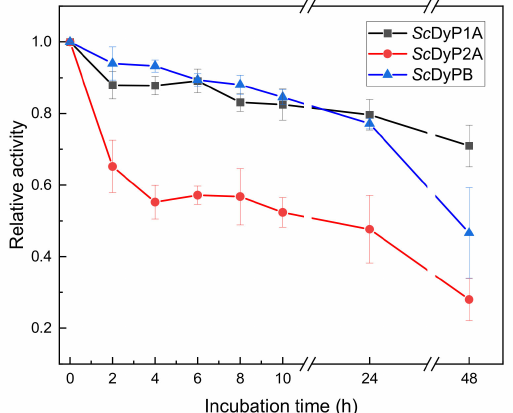
Figure 4. Thermostability of Sc DyPs. The enzyme stocks were incubated in 50 mM sodium citrate (pH 3.5), at 30 ◦ C. At selected times, the activities were measured using ABTS and 1 mM H 2 O 2 . Experiments were conducted in